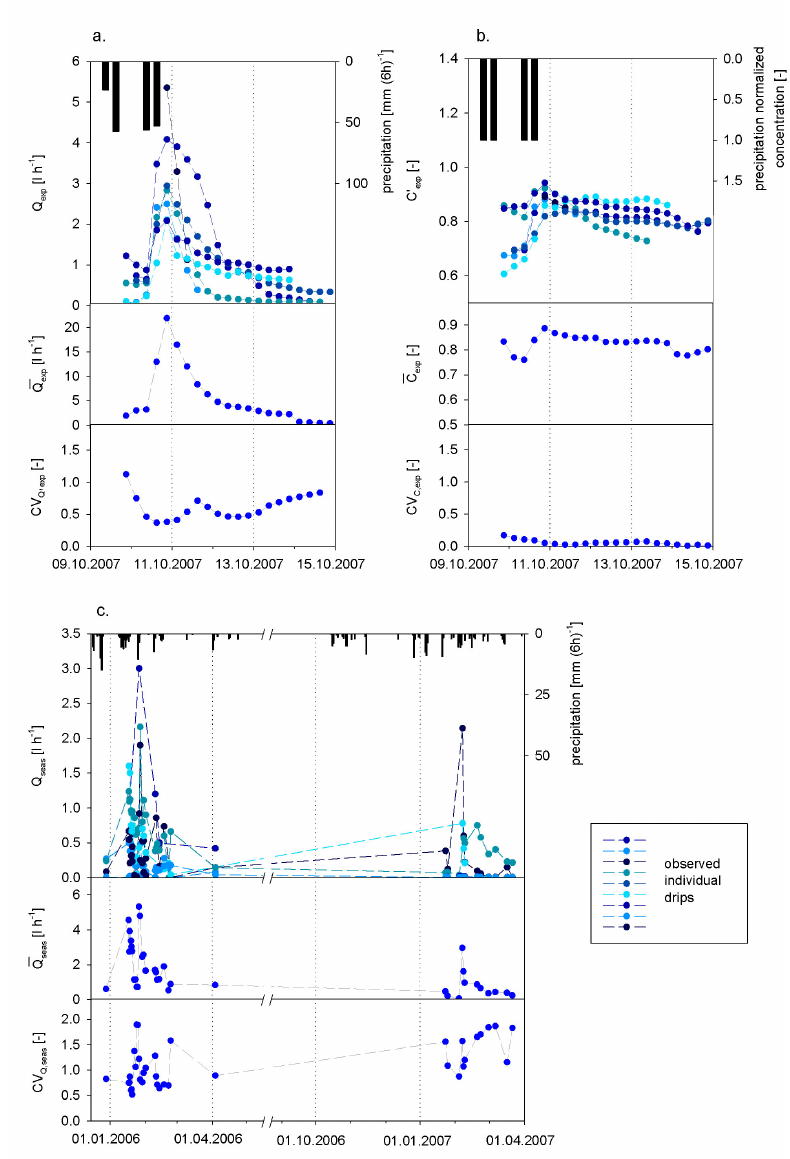
Fig. 2. Individual observations, integrated response and coefficient of variation of (a) drip rates during the sprinkling experiment (Lange et al., 2010), (b) drips’ normalized EC concentrations during the sprinkling event (Lange et al., 2010), and (c) drip rates at the seasonal time scale (Arbel et al.,